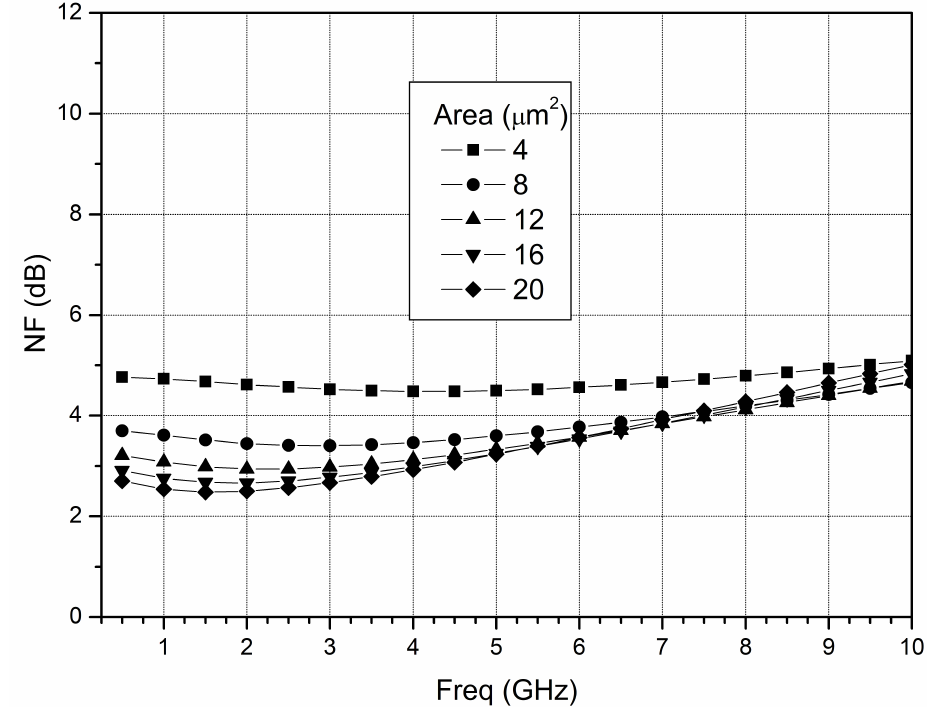
Figure 6. Noise figure vs. transistor area.